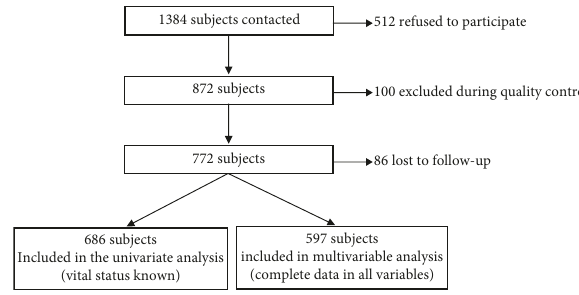
Figure 1: Flow chart of the sample. Table 1: Basal characteristics and causes of death of the sample included in the analysis.